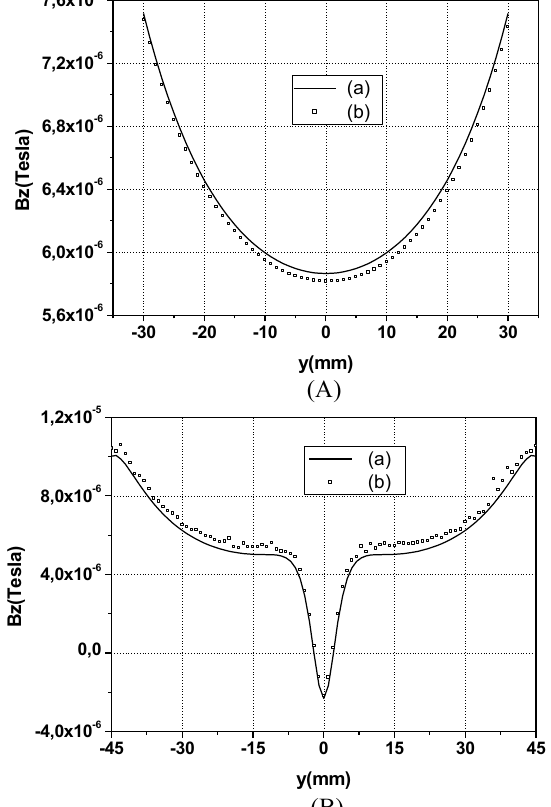
Figure APPENDIX 1: Determination of the induced eddy ! currents density j